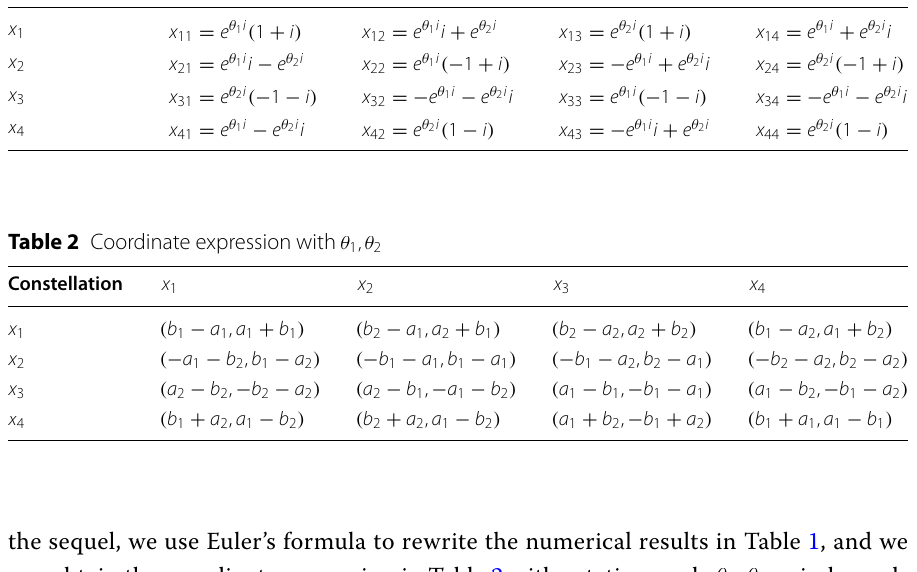
Table 1 Coordinate expression in Euler’s formula Constellation